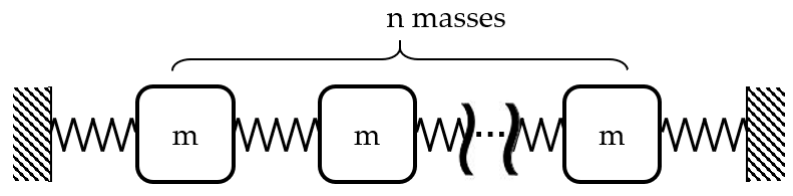
Figure 6. Sketch drawing of the numerical model.